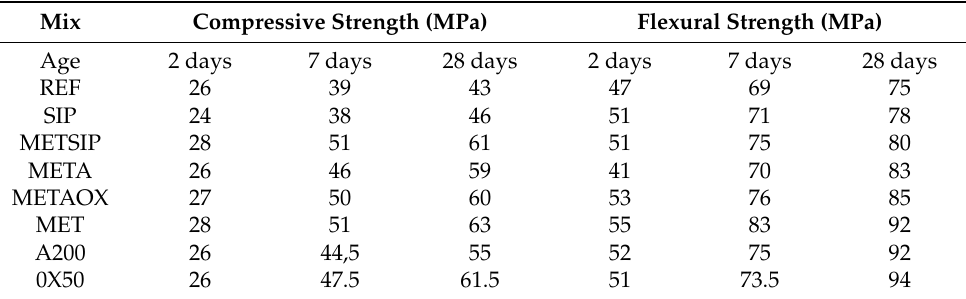
Table 3. Mechanical properties at 2, 7, and 28 days.